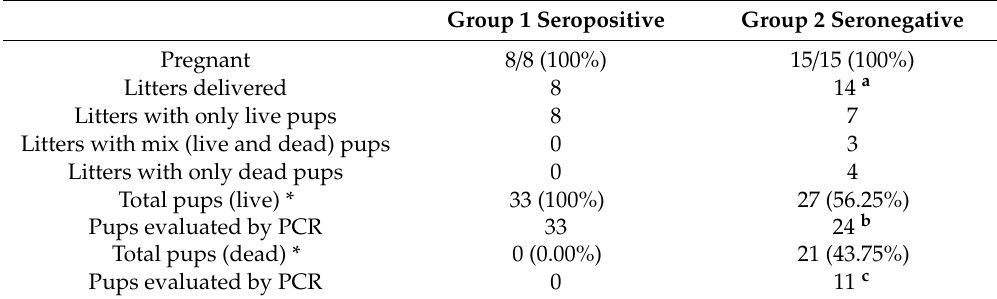
Table 2. Congenital infection outcomes for live versus dead pups. Group 1 Seropositive Group 2